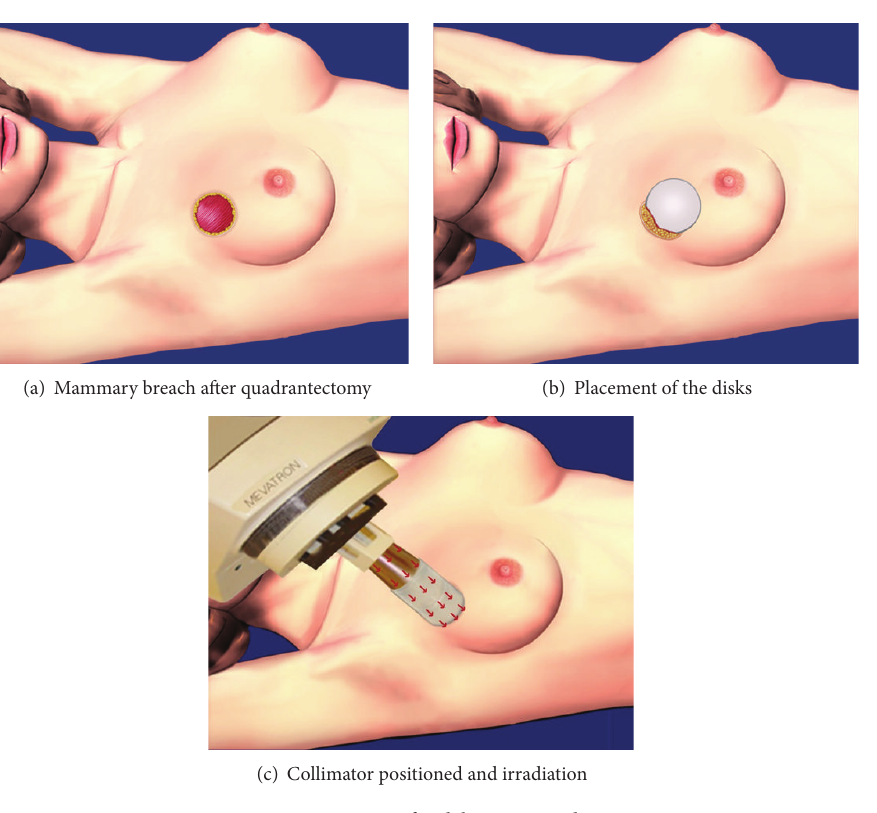
Figure 1: Preparation for delivering irradiation.